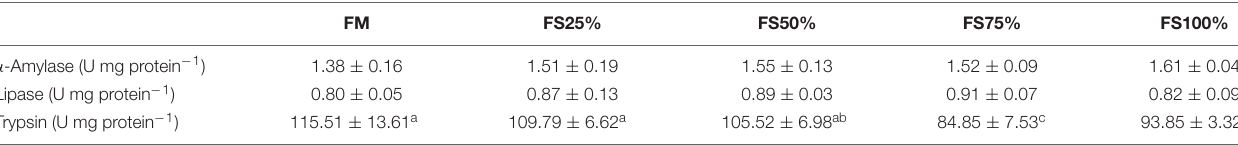
TABLE 7 | Digestive enzyme activities in hepatopancreas of shrimps fed with different experimental diets for eight weeks (means of triplicate ± SD). FM FS25% FS100% α -Amylase (U mg protein − 1 )